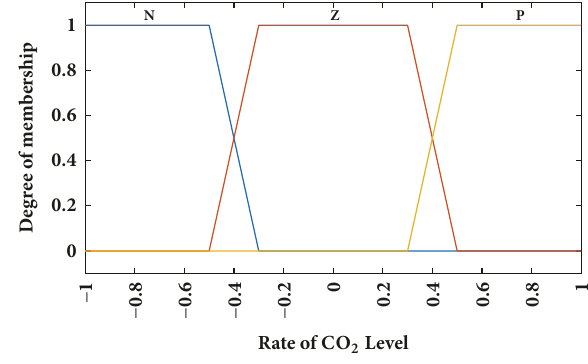
Figure 12: MFs of static pressure difference.